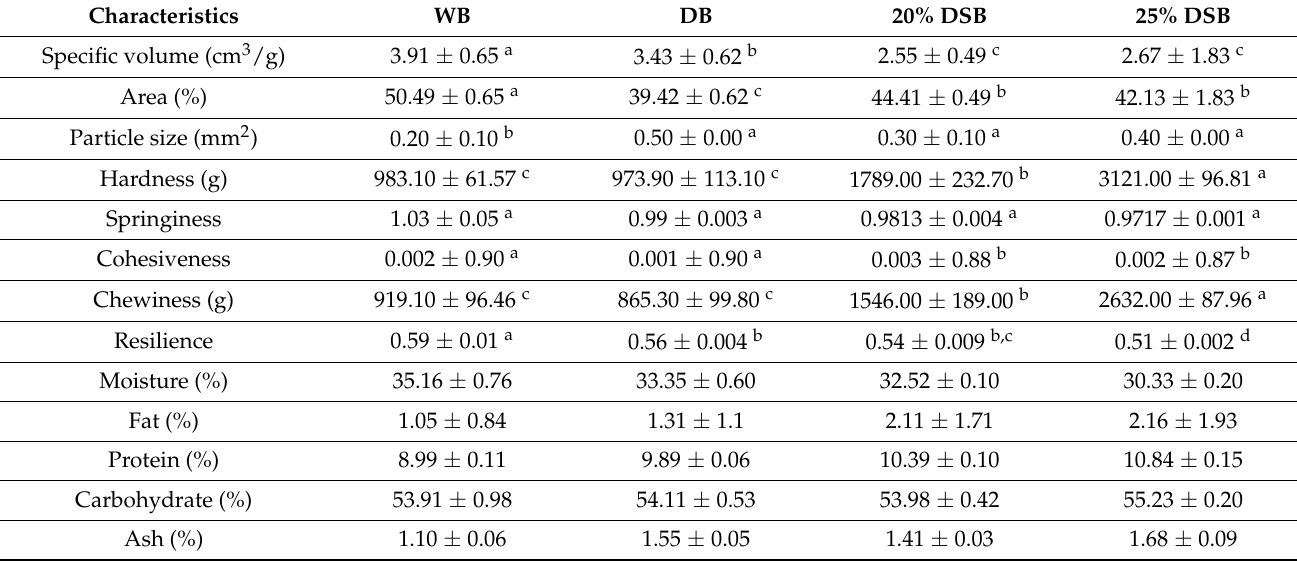
Table 5. Texture profile analysis and proximate analysis of the different bread